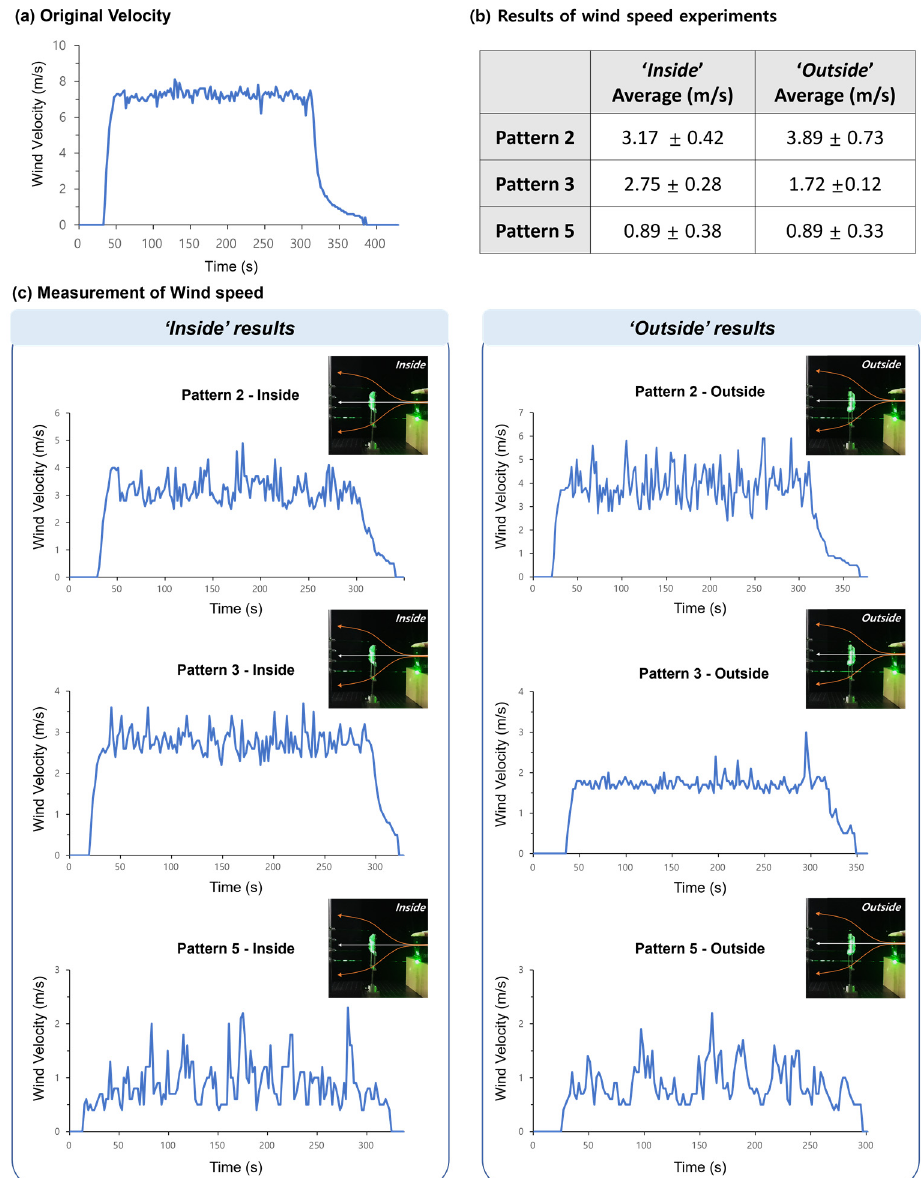
Figure 6. The results of the wind speed experiments. ( a ) Airflow velocity of the generated wind. ( b ) Mean and standard deviation of air speed through each model. ( c ) Wind speed graphs obtained when the wind passed the origami structures.